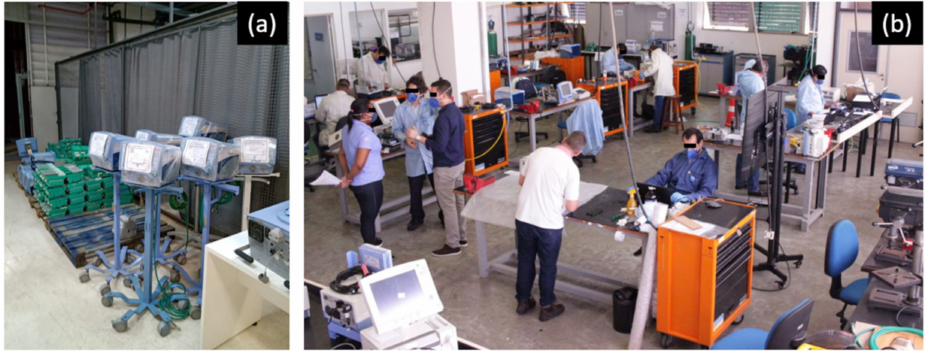
Figure 4. Main workspaces of maintenance line of ventilators implemented at Reference Unit: ( a ) receiving, cleaning, and disinfection area, and ( b ) general maintenance